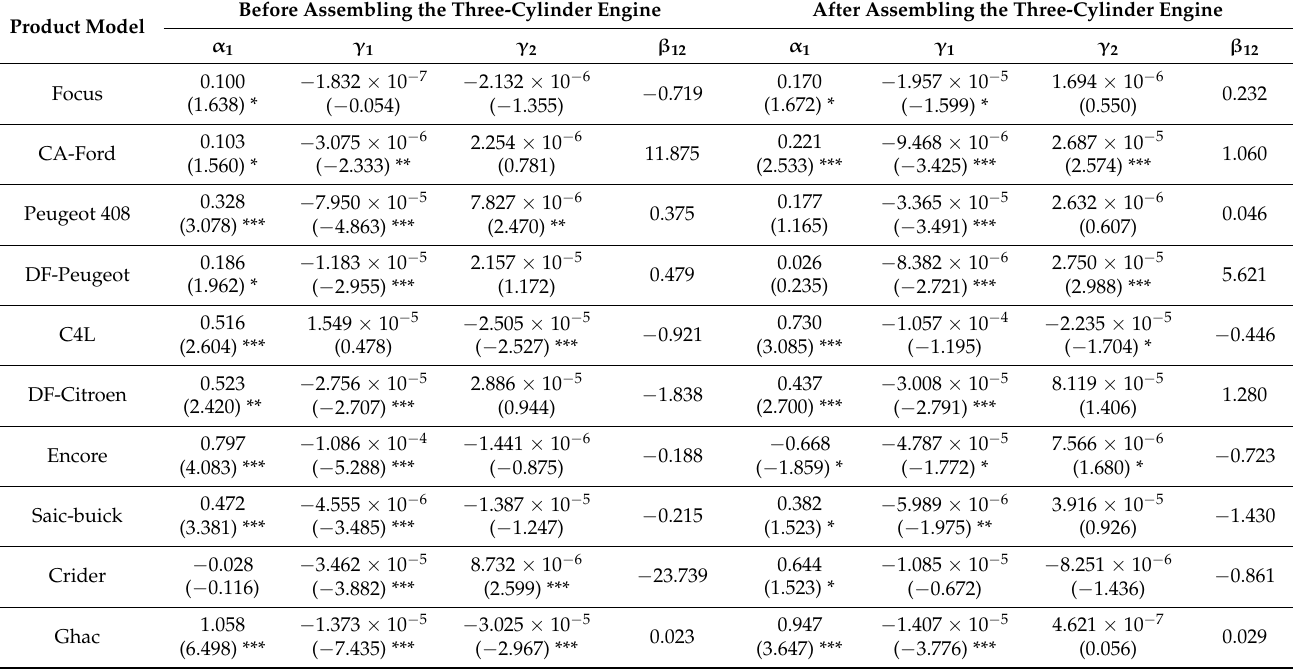
Table 3. Lotka–Volterra model results of vehicle models and enterprise